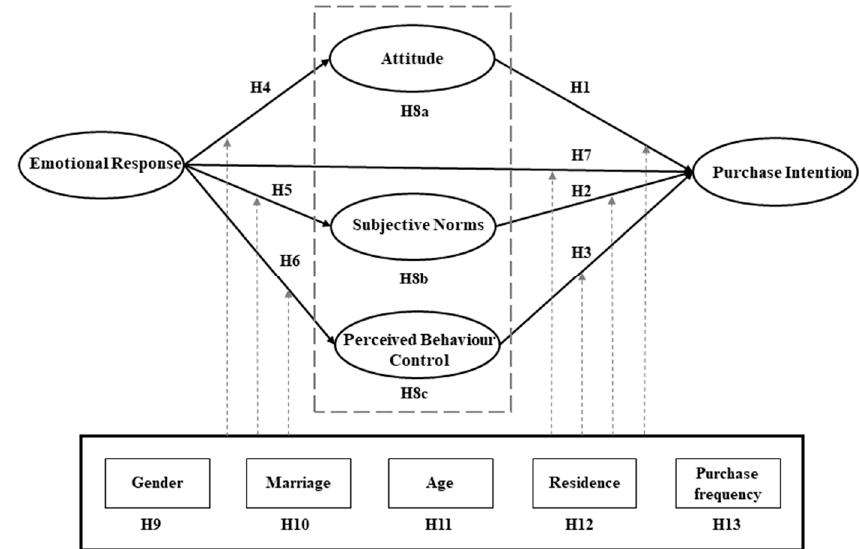
Figure 1. The theoretical model of consumers’ CCAP purchase intentions.